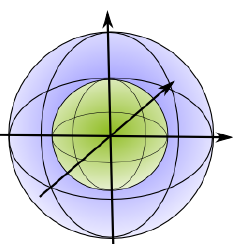
Figure 3. Histogram bins (shells are different colored